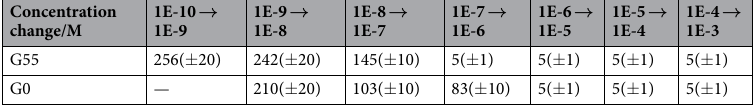
Table 3. Response times (t 95% /s) of G55 and G0.